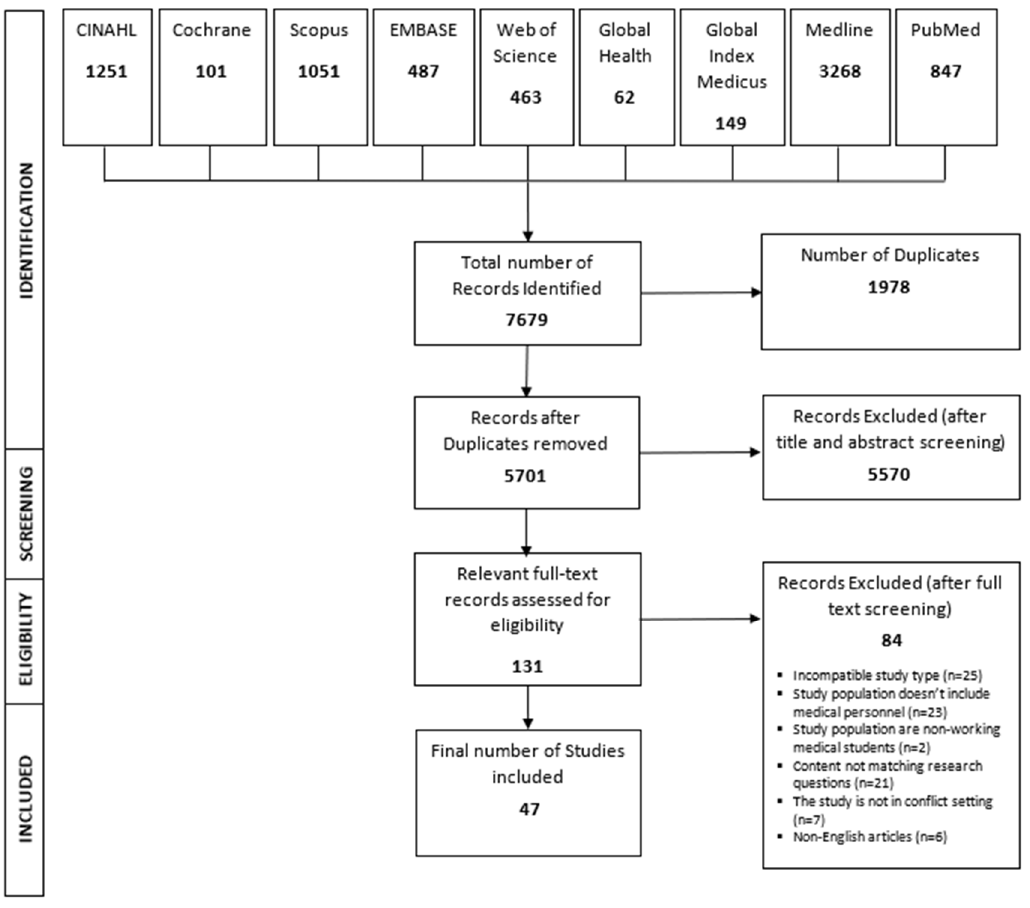
Figure 1. The PRISMA flow diagram presenting the selection process of the scoping review.